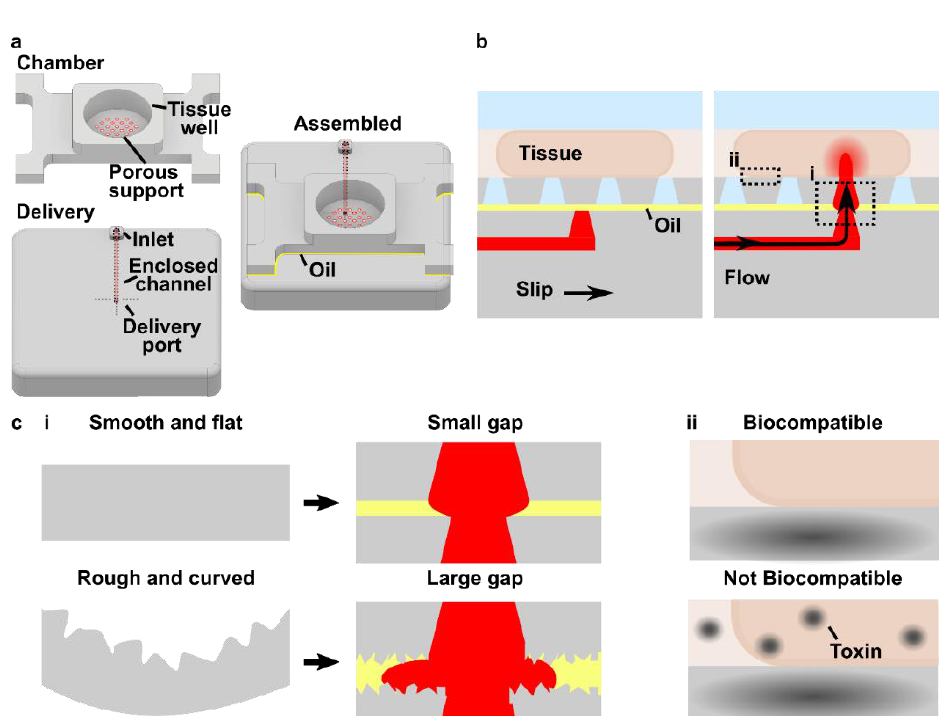
Figure 1. Conceptual design of a 3D printed SlipChip with movable ports. ( a ) AutoCAD Inventor 3D drawing of the chamber and delivery components, with the key features of each component labeled, and a schematic of the device assembled with the oil layer. ( b ) Sideview of the assembled device, loaded with a tissue slice, before (left) and during (right) alignment and fluid delivery into the slice. Boxes show areas highlighted in panel c. ( c ) The two major challenges for developing a movable port SlipChip were to ensure that (i) the surfaces were both smooth and flat, thus preventing leaks by minimizing the size of the gap between components, and (ii) the material was sufficiently biocompatible.